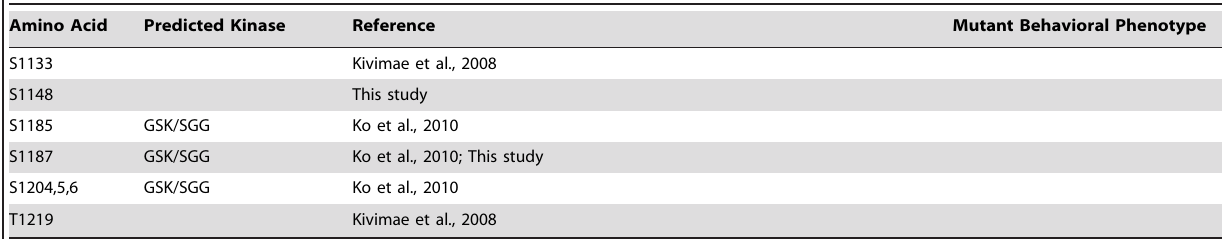
How do T610 and S613 set the pace of the